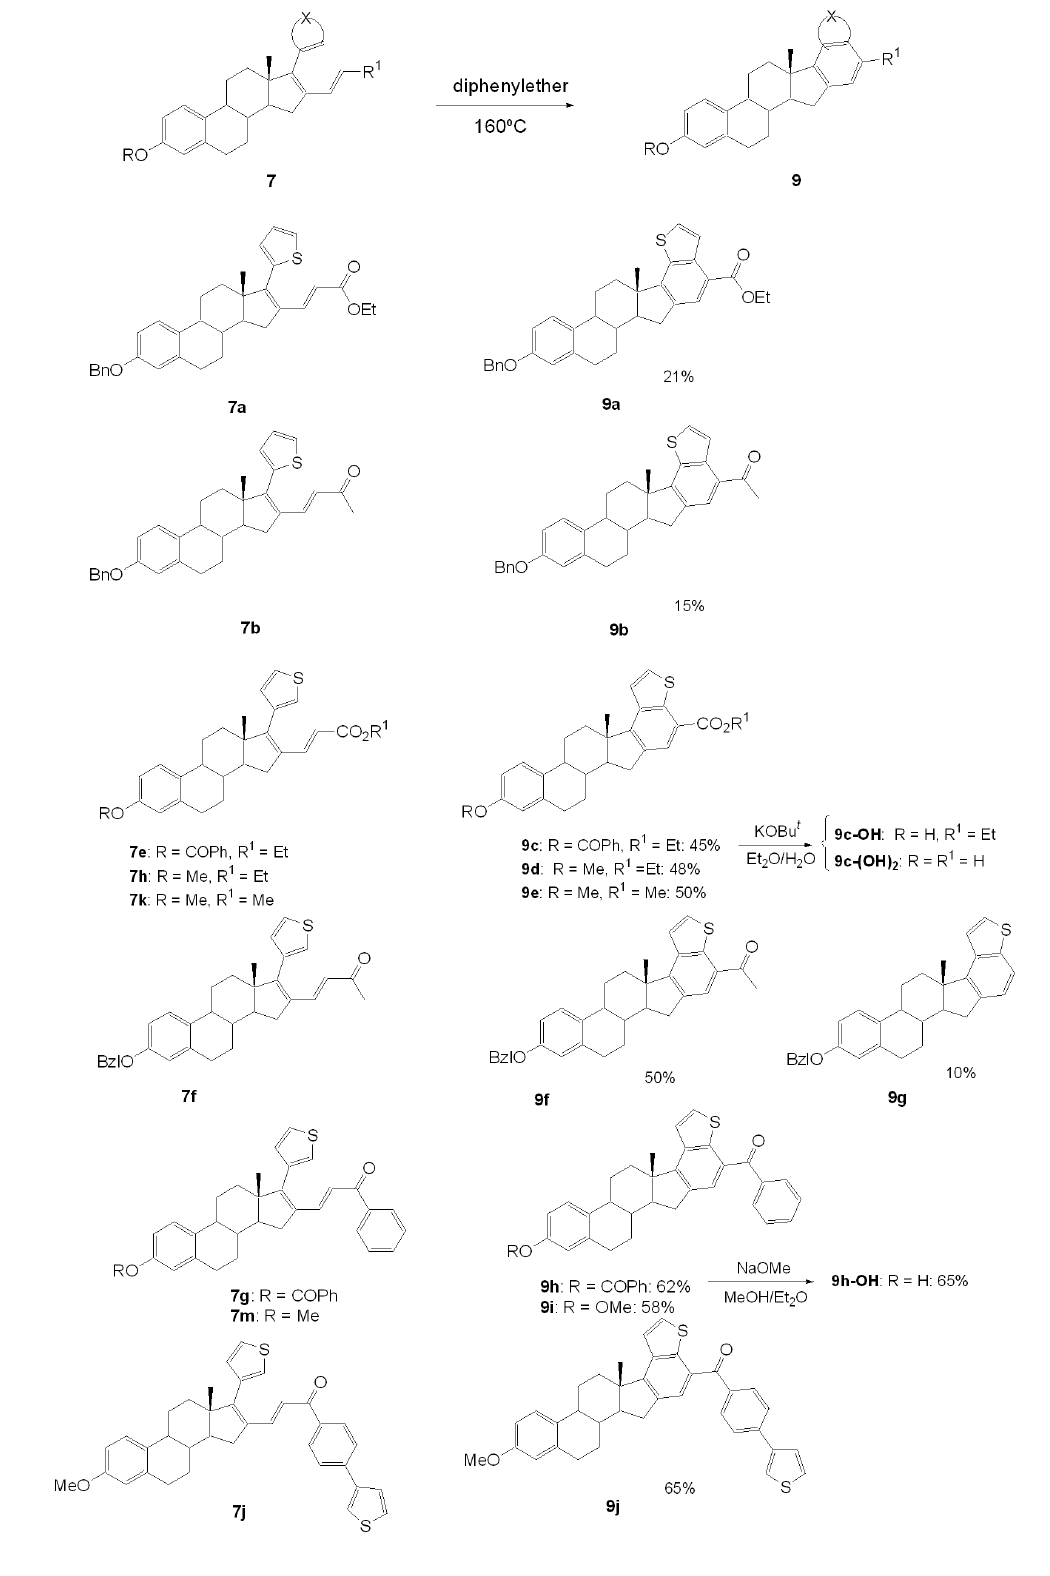
Scheme 8 Thermal cyclization of estrane trienes of type 7